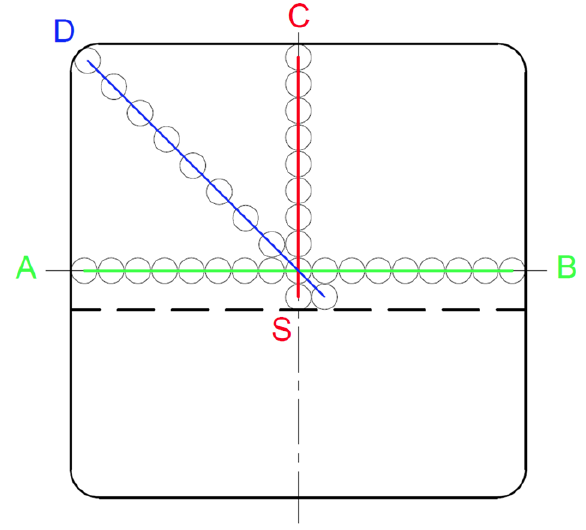
Figure 4. Billet cross-section with marked points for carbon content measurement.